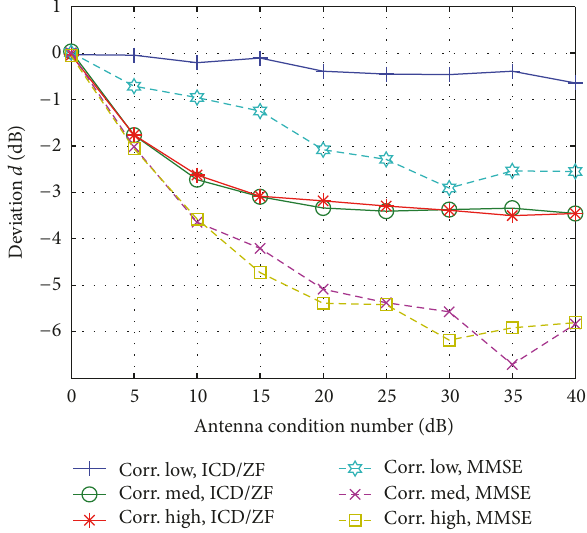
Figure 13: Deviation 𝑑 versus antenna condition number for DLSCH processing off, ideal channel estimation; low, medium, and high channel correlation; ICD/ZF and MMSE